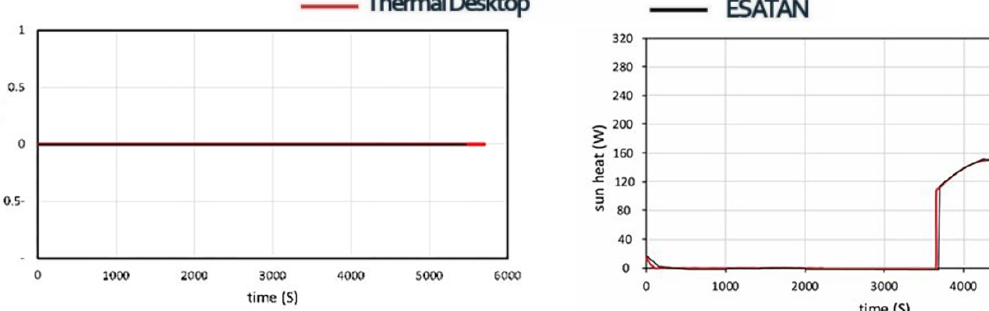
Fig. 4: External heat fluxes on solar panel +X as predicted by ESATAN and Thermal Desktop (node